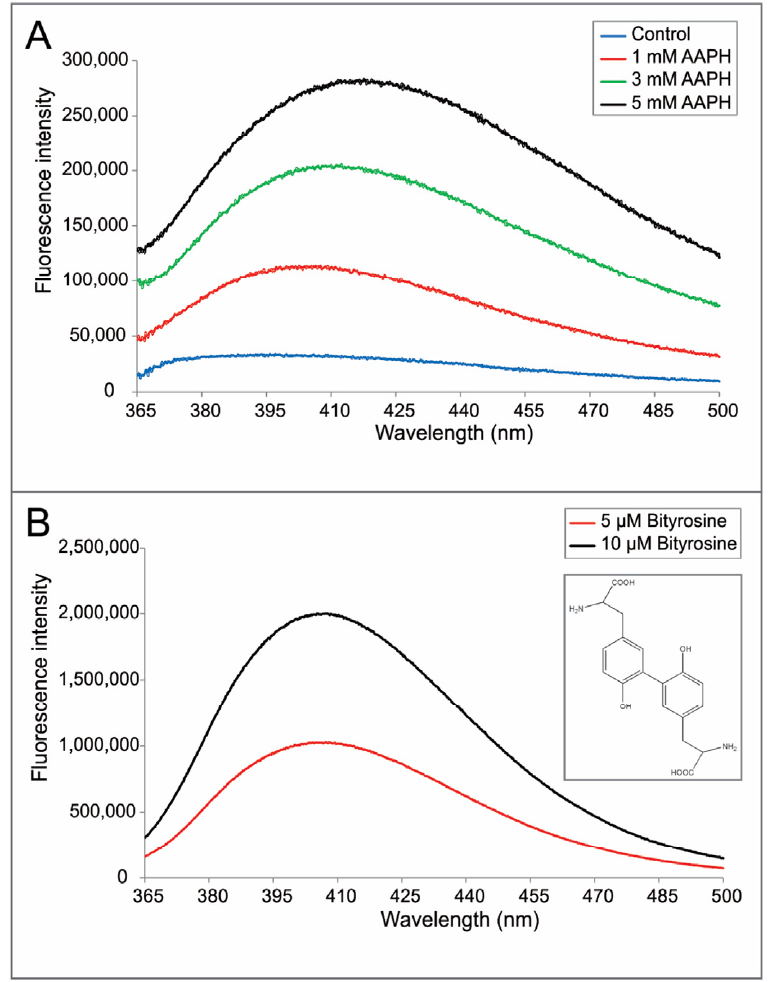
Figure 5. ( A ) Intrinsic fluorescence spectra of the control sample (no AAPH stressed mAb1) and mAb1 after stressing by 1, 3, and 5 mM AAPH. ( B ) Intrinsic fluorescence spectra of bityrosine standard at 5 µ M and 10 µ M. Inset: chemical structure of